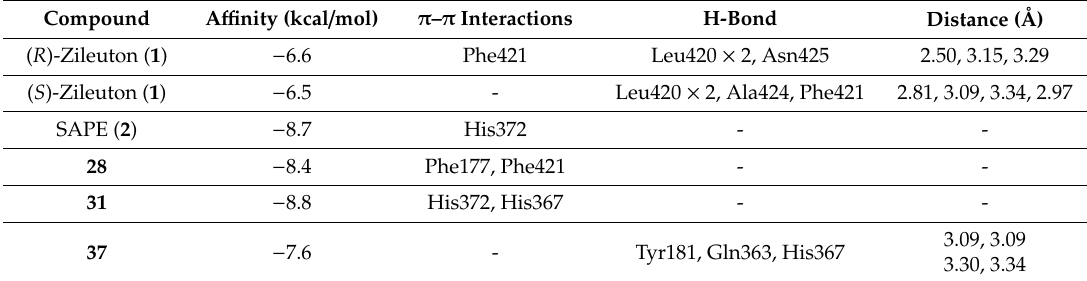
Table 2. Molecular modeling results predicting a ffi nity for the active site, π – π interactions, and hydrogen bond